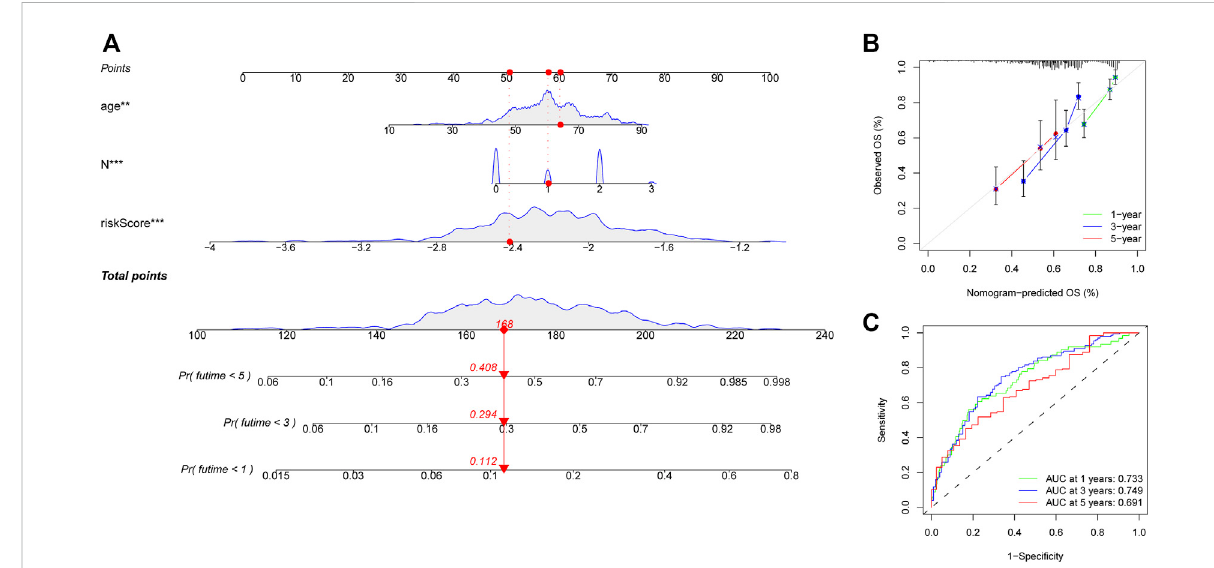
FIGURE 11 Construction of a nomogram for predicting survival of HNSCC patients. (A) Nomogram using two clinical traits (N stage and age) and the risk score. (B,C) The calibration and ROC curves for determining the reliability of the nomogram to predict one-, three-, and fi ve-year survival